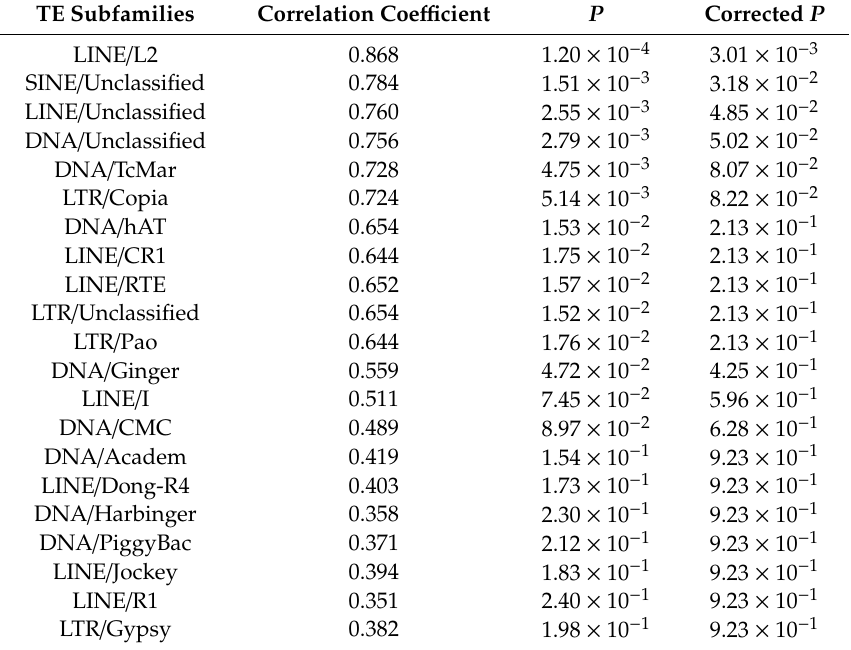
Table 2. TE loads are significantly correlated with genome